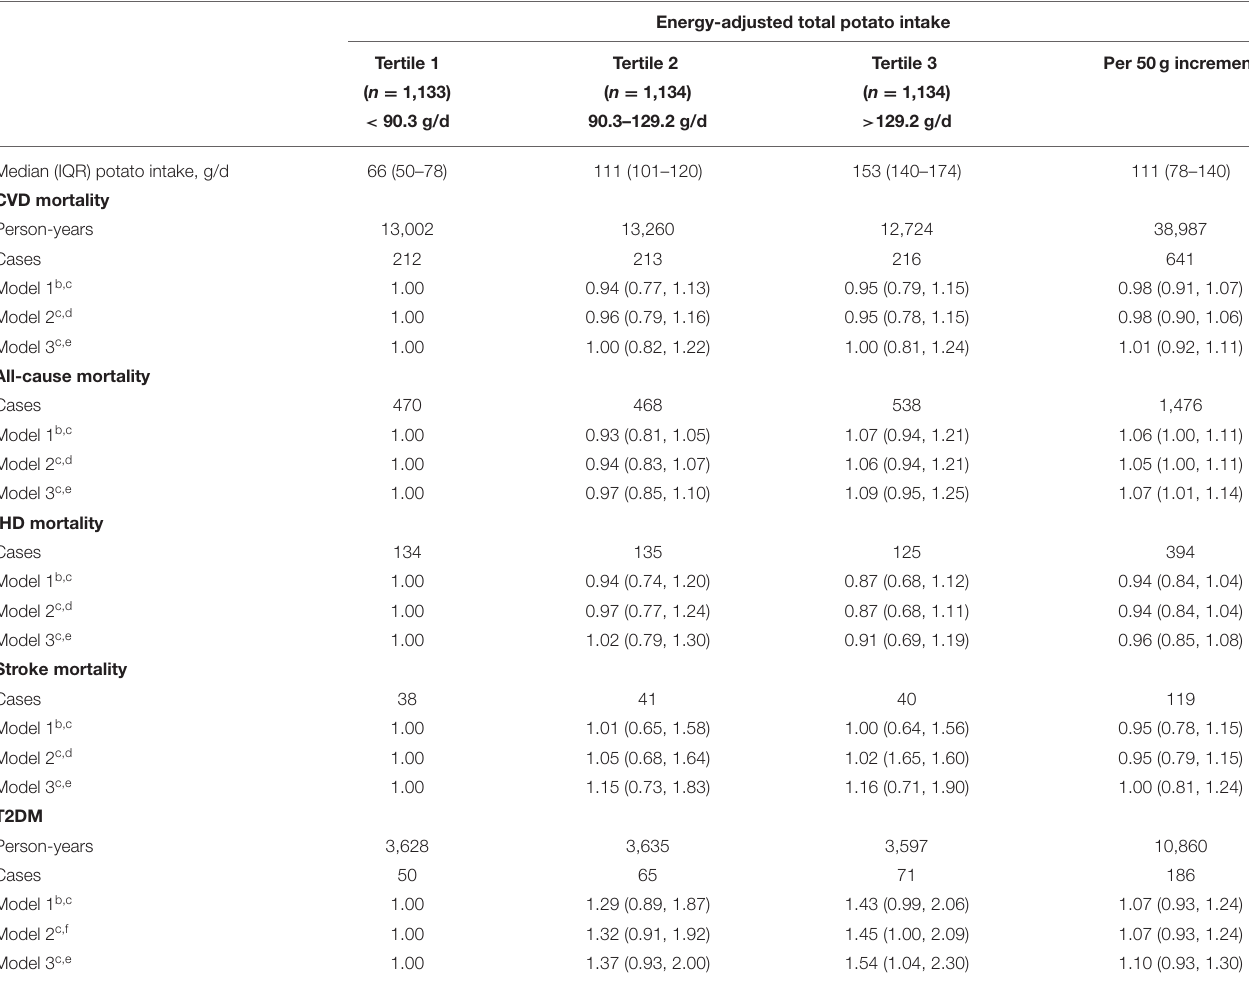
TABLE 2 | Hazard ratios (HRs) for total potato intake in relation to CVD, all-cause, IHD, stroke mortality, and T2DM incidence in 3,401 patients from the Alpha Omega Cohort a